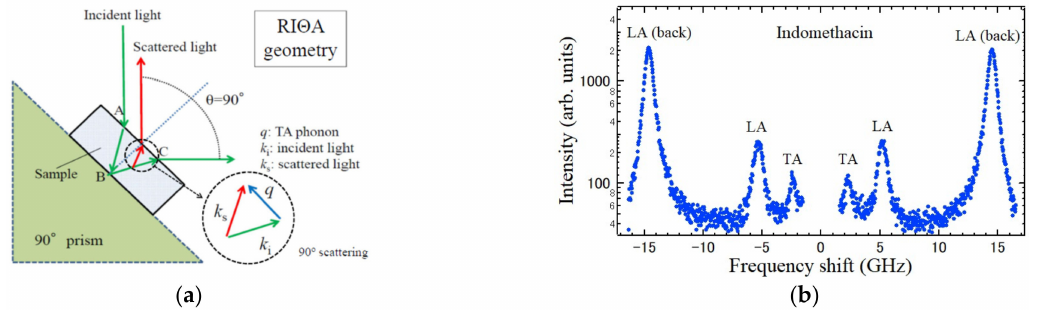
Figure 17. ( a ) Scattering geometry of the reflection-induced Θ A scattering to observe TA modes at the backward scattering geometry. By the reflection of an incident light at the point B, right angle scattering is observed. ( b ) The Brillouin scattering spectrum of the reflection induced Θ A scattering of a glassy IMC. The LA peaks of backward scattering were also observed [95].